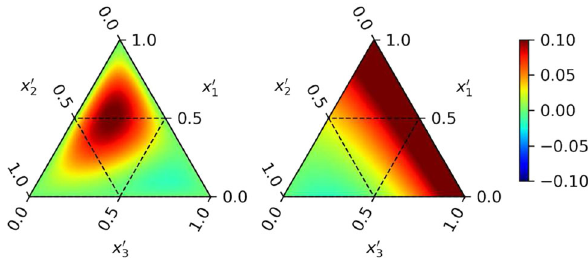
Fig. 3 Dependenciesoftheleading-twistprotonLCDAs V 1 − A 1 + 2 T 1 in Eq. (42) (left) and of the twist-5 proton LCDAs V 4 − V 5 + A 4 + A 5 +